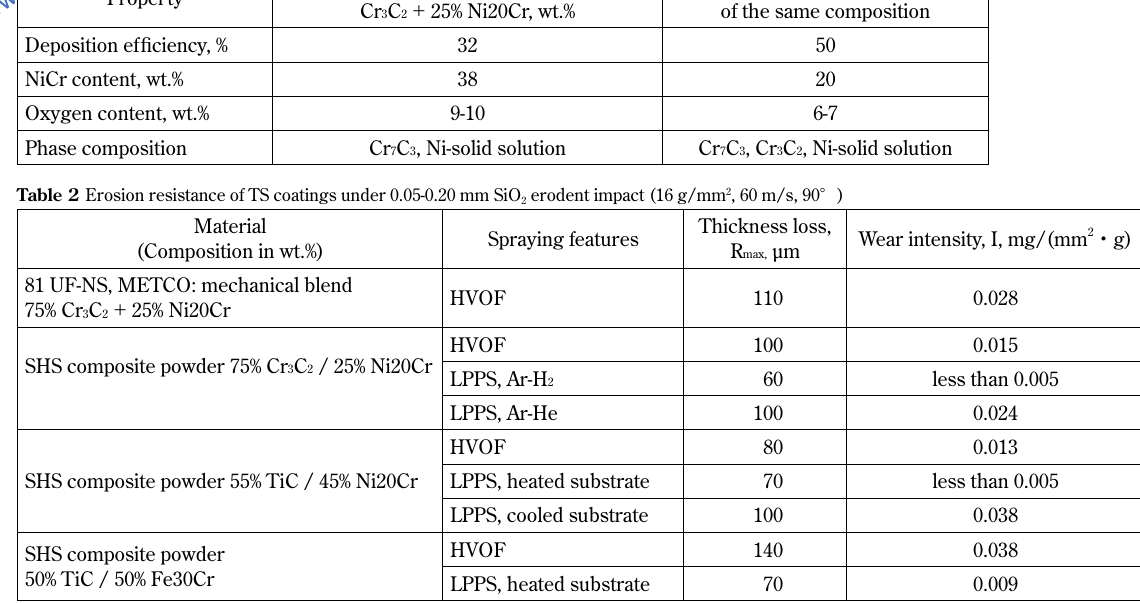
Table 1 Properties of HVOF coatings from Cr 3 C 2 / NiCr powders Property Deposition efficiency, %